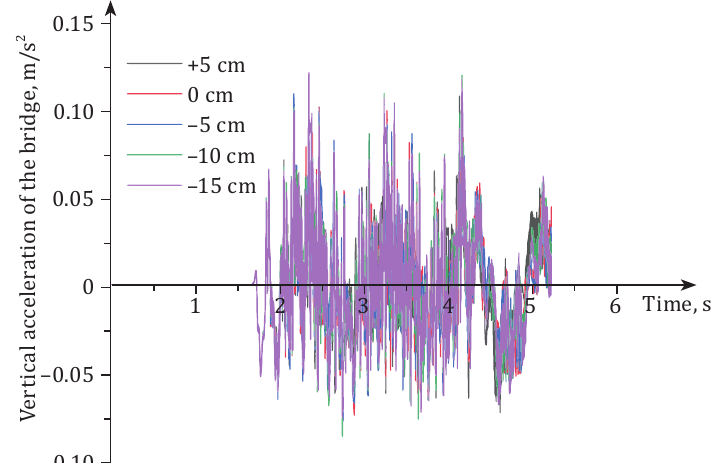
Figure 18. Comparison of vertical acceleration time history at bridge midspan